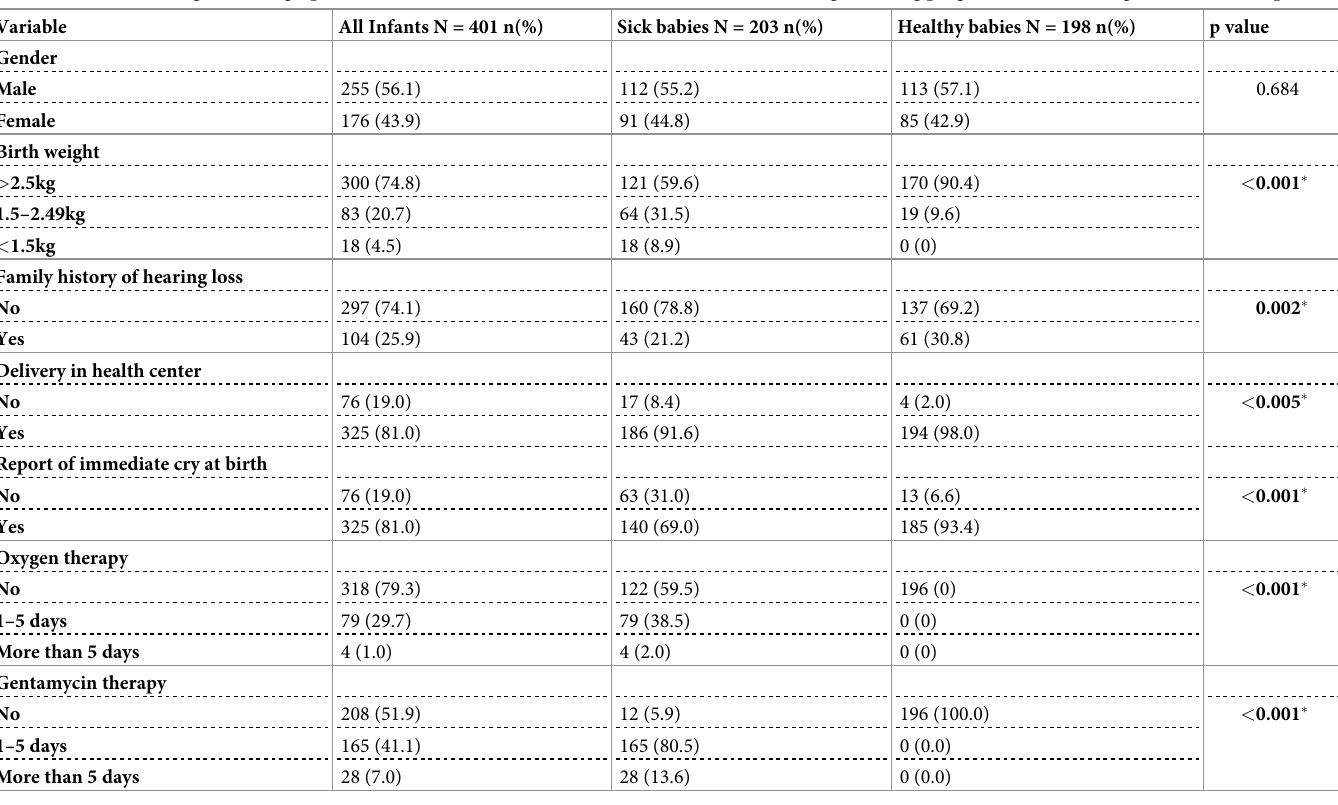
Table 1. A table showing the demographic characteristics of the infants (n = 401) enrolled in a hearing screening program at Mbarara Regional referral